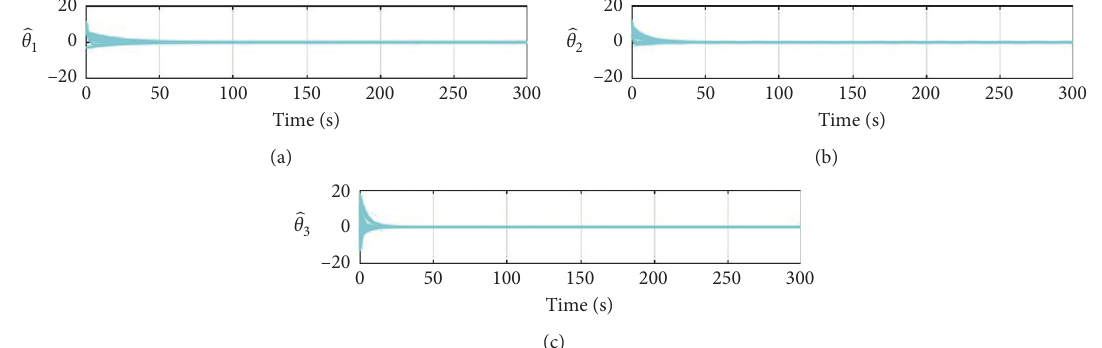
Figure 10: Trajectories of 􏽢 θ